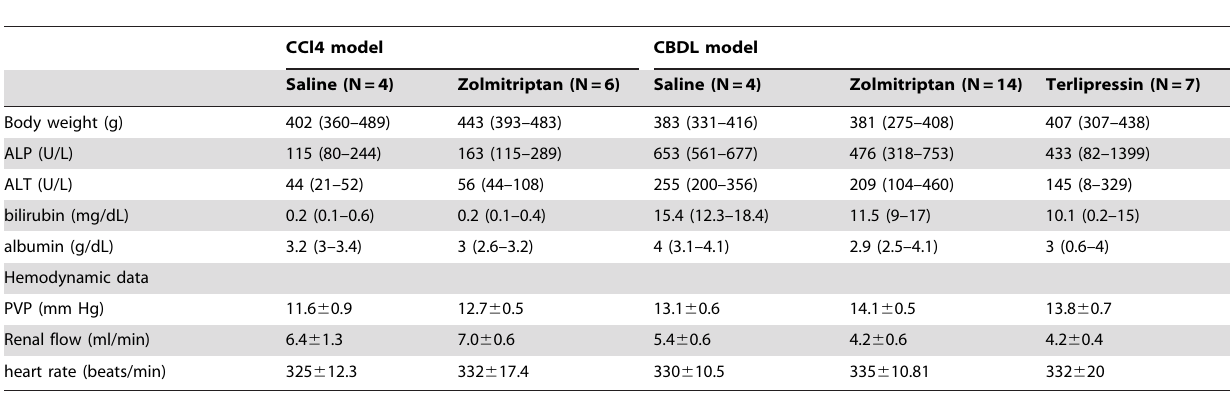
Table 1. Body weight, biochemical data and basal hemodynamic parameters of rats with portal hypertension which received i.v. infusion of zolmitriptan, terlipressin or